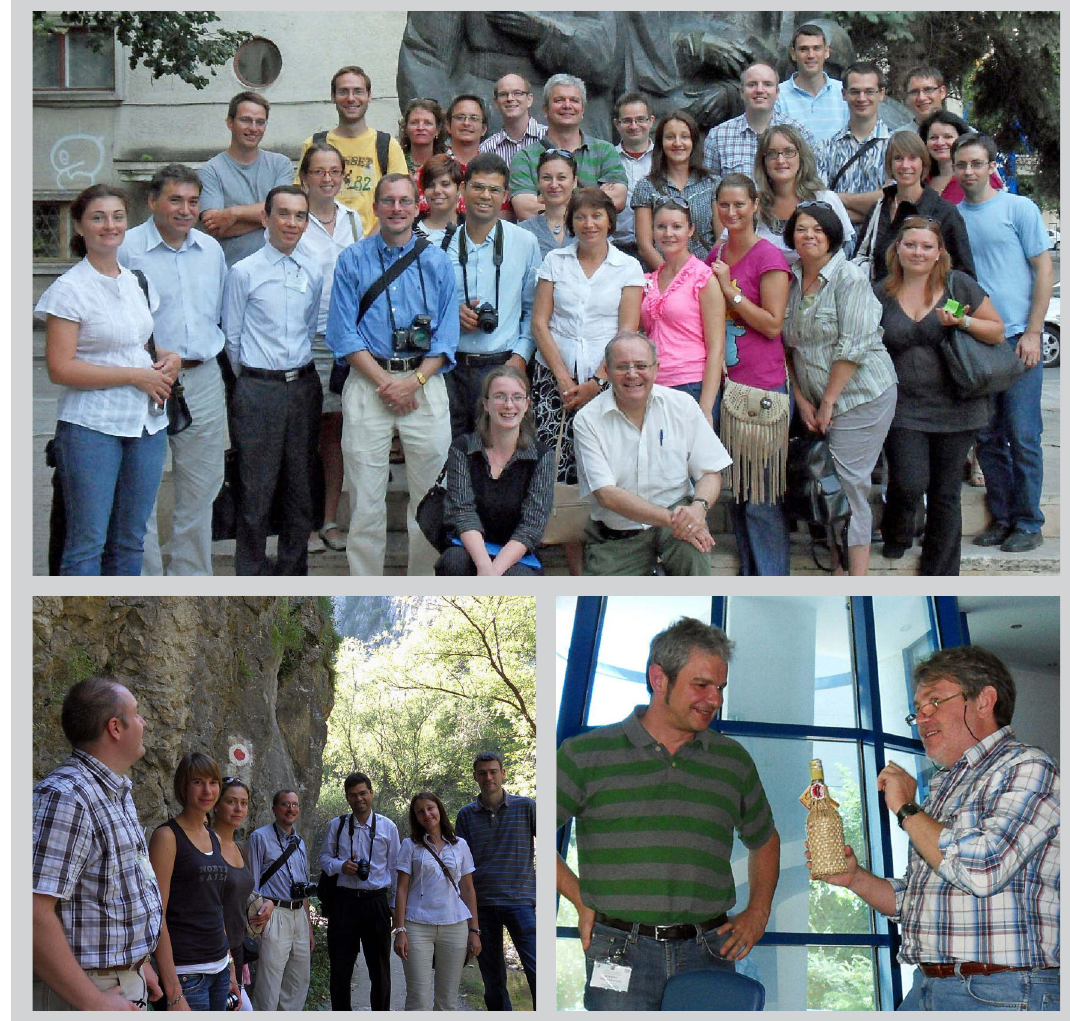
Figure 4 (above): At the end of the historical tour of Cluj Napoca. Figure 5 (left below): A rest in the middle of Turda Canyon, from right: Oliver Arnolds and Kathrin Rein- heimer (PhD students, IT Karlsruhe), Anca Bejenariu and Peter Szabo (TU Den- mark), Víctor Hugo Rolón- Garrido (TU Berlin), Daniela Coblas and Catalin Mihai Balan (PhD students, PU Bucharest). Figure 6 (right below): Norbert